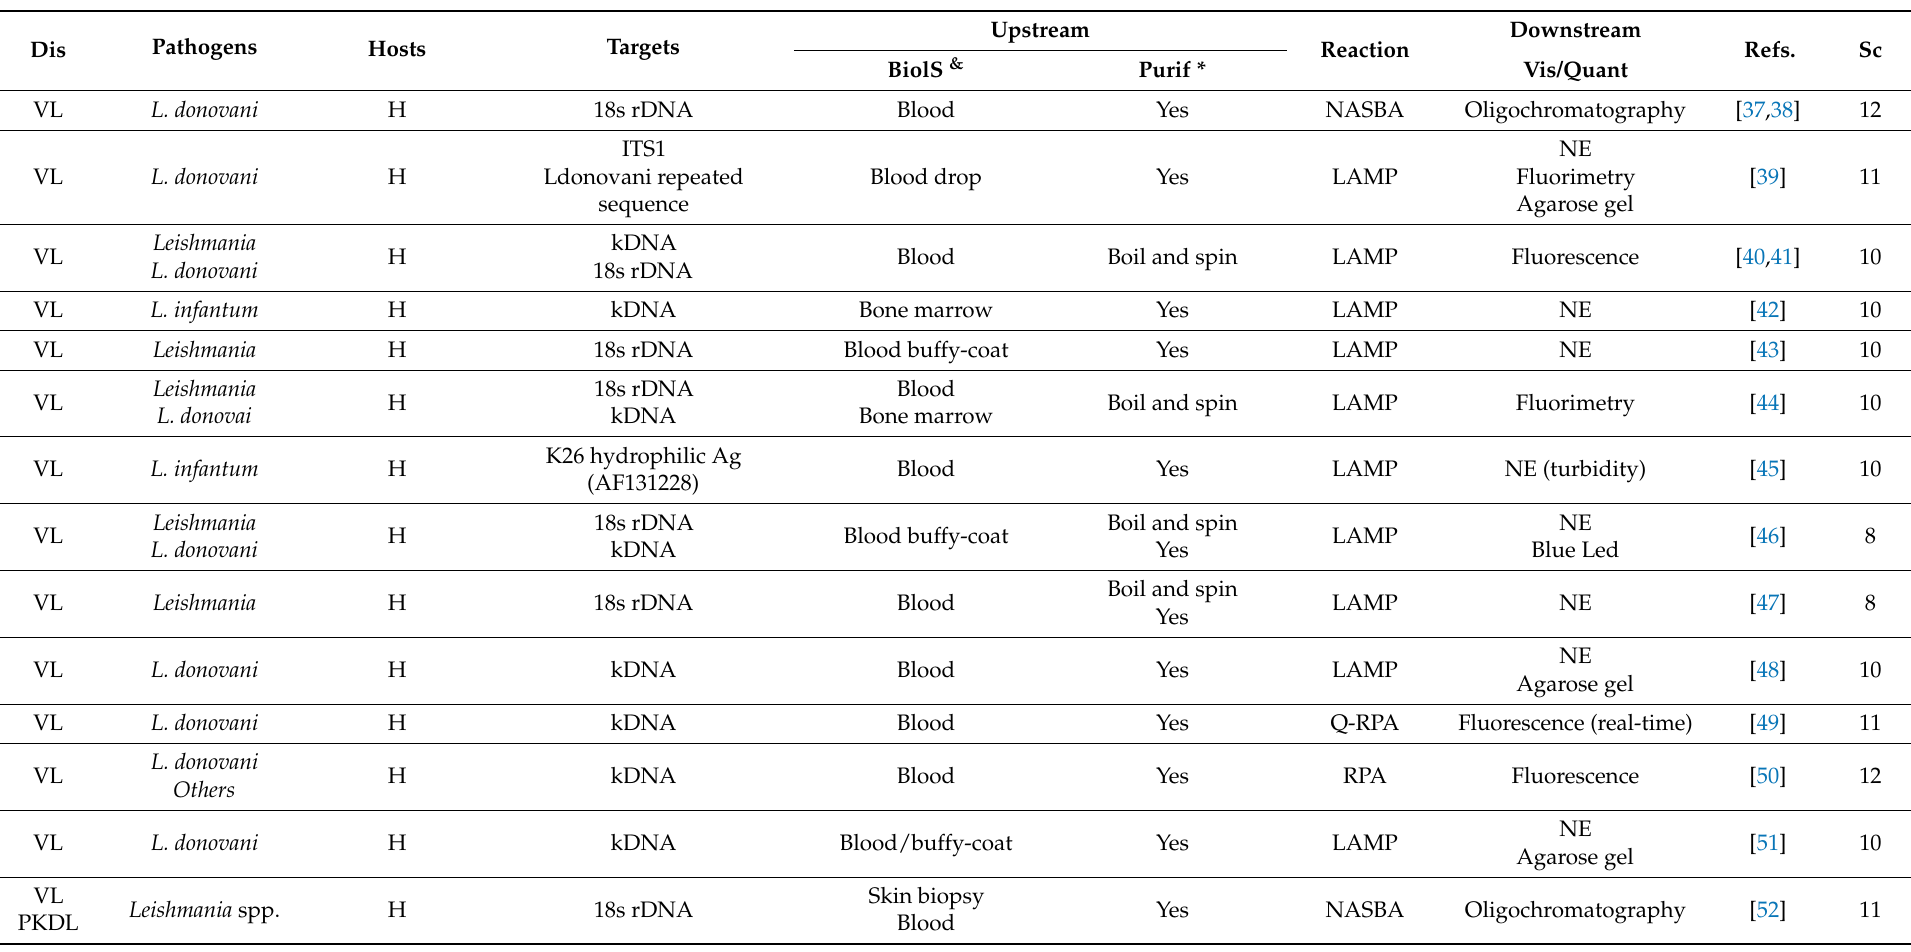
Table 2. Methodologies needed to process biological samples reported in the literature involving isothermal amplification of nucleic acids: from biological sampling to results acquisition and their field translation